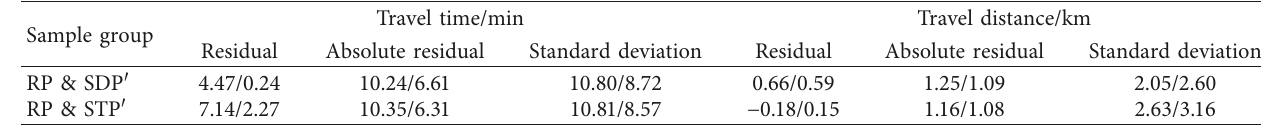
Table 9: The deviation between the actual and the shortest paths for commuters/noncommuters on a working day.